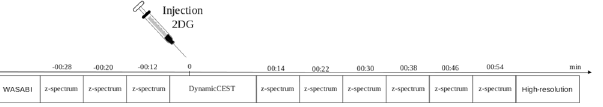
Figure 1. Timing of the experiment. (syringe image from https://www.dreamstime.com/stock-illustration- syringe-icon-white-background-image42045561, author: Konstantin